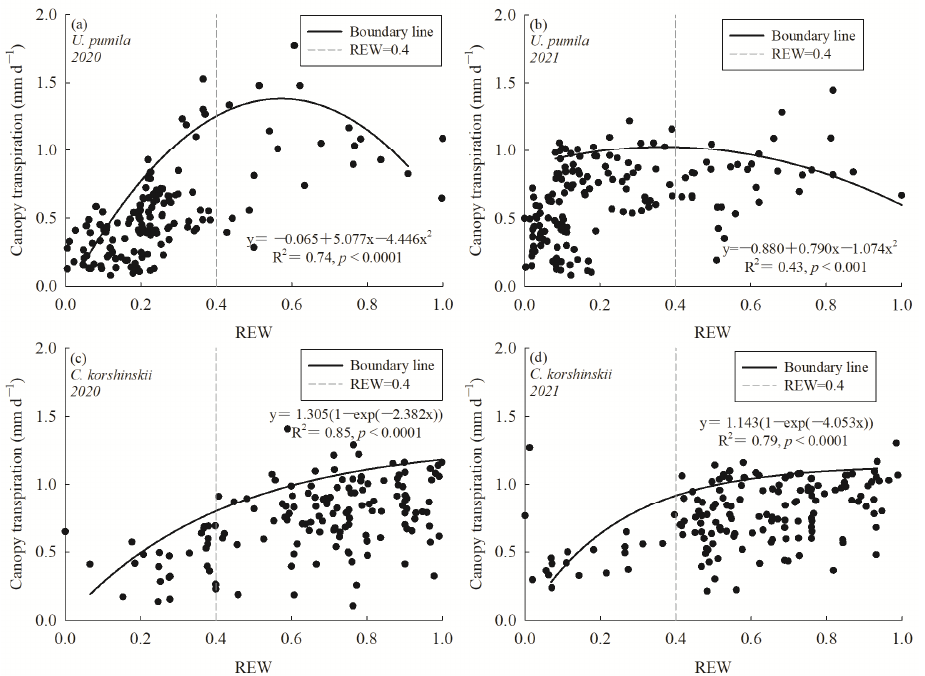
Figure 5. Response of canopy transpiration per ground area to the relative extractable soil water and boundary line analysis for U. pumila and C. korshinskii in 2020 ( a , c ) and 2021 ( b , d ).